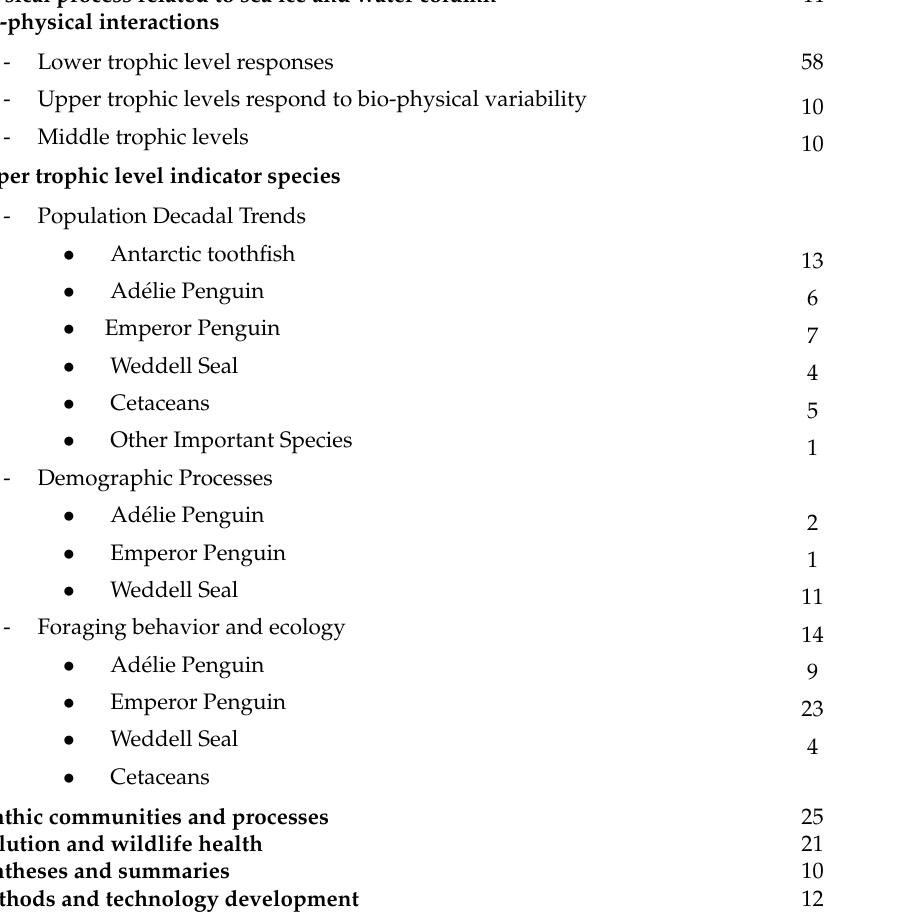
Table 2. Primary topics (and sub-topics) covered by U.S. researchers in the Ross Sea and number of published papers within each topical area (from 2010–April